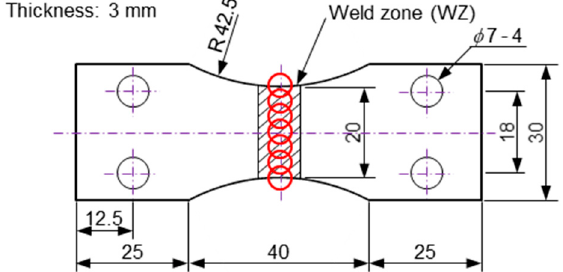
Figure 9. The shape and dimensions of FSWed samples. The dimensions are expressed in millimeters. The red circles are the fields of view of CL.